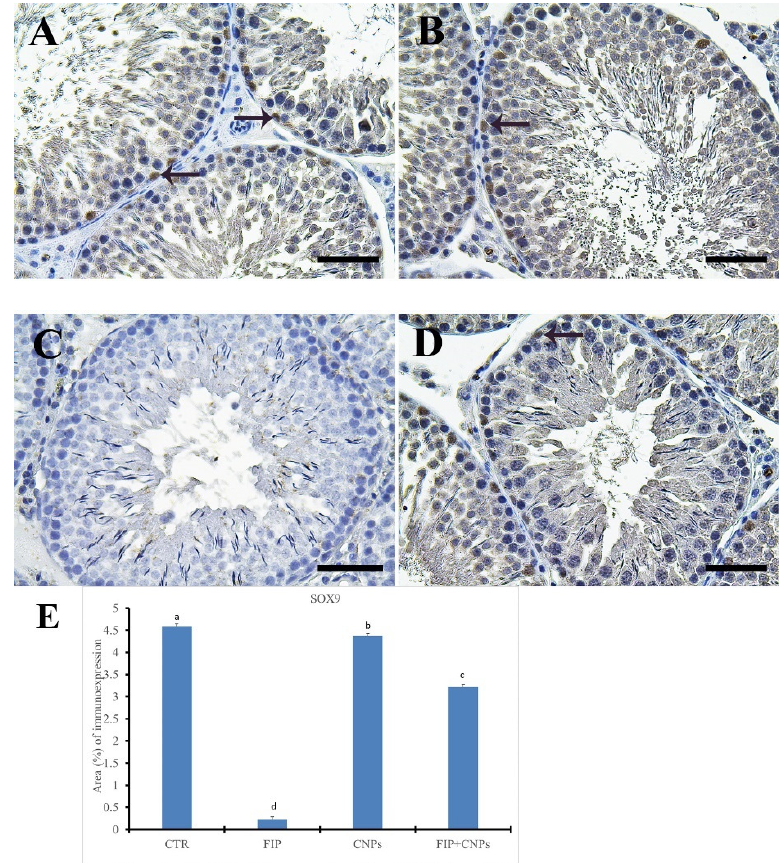
Figure 9. Immunohistochemical staining of rat testes by Sox9. ( A ) control group showed the strong positive Sox9 reaction in Sertoli cells (arrows). ( B ) CeNPs group. ( C ) FIP group showing negative Sox9 in Sertoli cells. ( D ) FIP treated with CeNPs showed strong positive Sox9 reaction in Sertoli cells (arrows) . ( E ) Semi-quantification of Sox9 in the testicular tissues in different groups. Scale bar = 50 µm . Data expressed as mean ± SE, analyzed using one-way ANOVA at p ≤ 0.05.